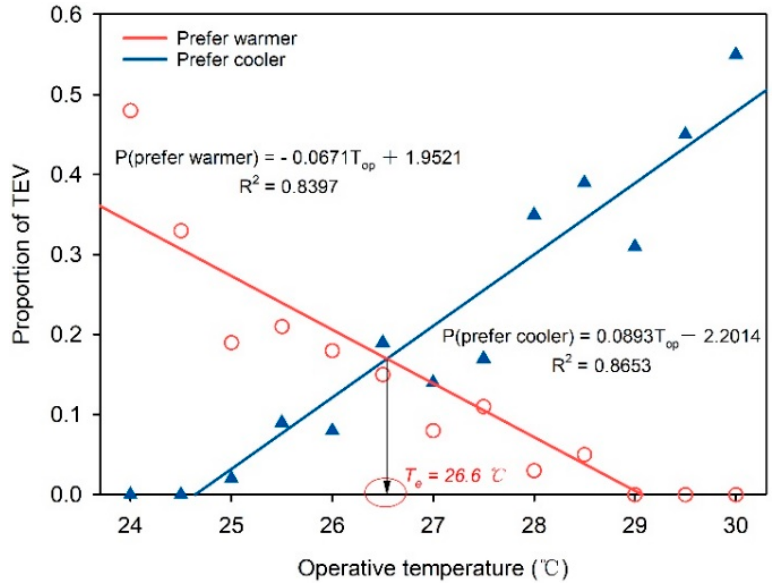
Figure 8. Regression analysis of expectative temperature.